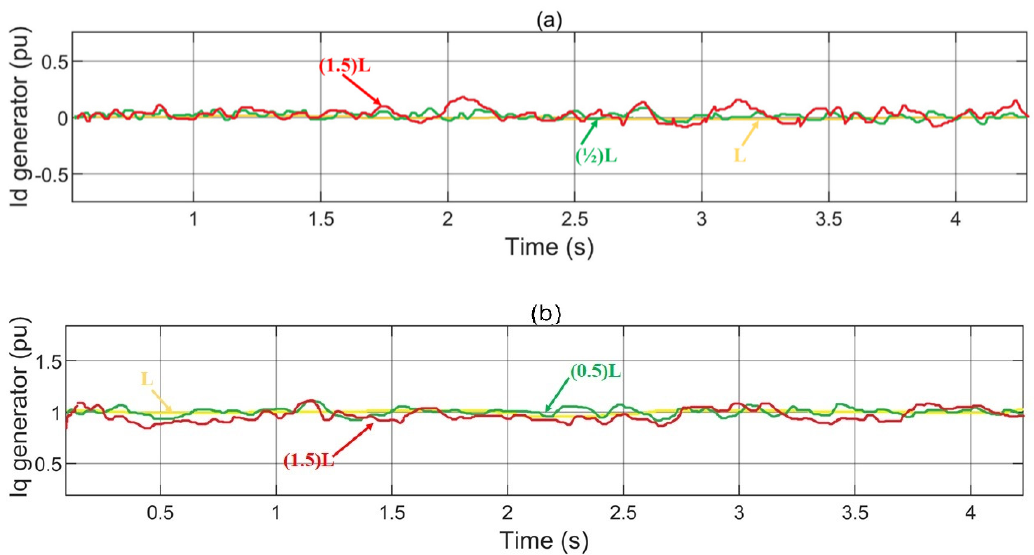
Figure 20. Parameter robustness analysis under inductance variation ( a ) d-axis stator current ( b ) q-axis stator current. Table 5. Comparison of FCS-MPC and classical PI controller.